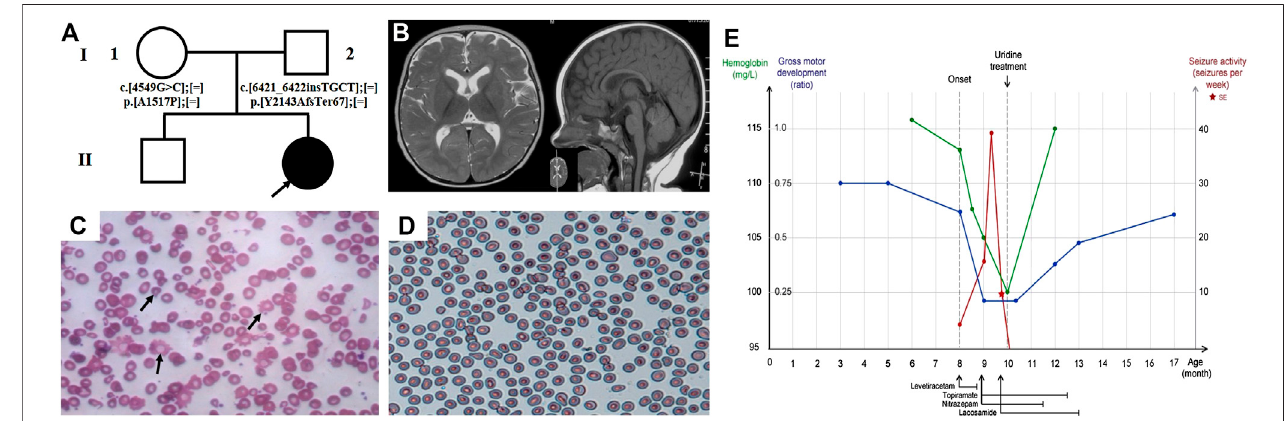
FIGURE 2| Clinical features and uridine response ofpatient 2withCAD de fi ciency. (A) Family pedigree of patient 2. (B) Brain MRI at 8.5-months. Peripheral blood smear (C) before treatment and (D) after treatment. (E) Clinical overview during the course of disease. Gross motor development represented as the observed development age according to the Nelson Gross Motor Development Milestones divided by the patient ’ s biological